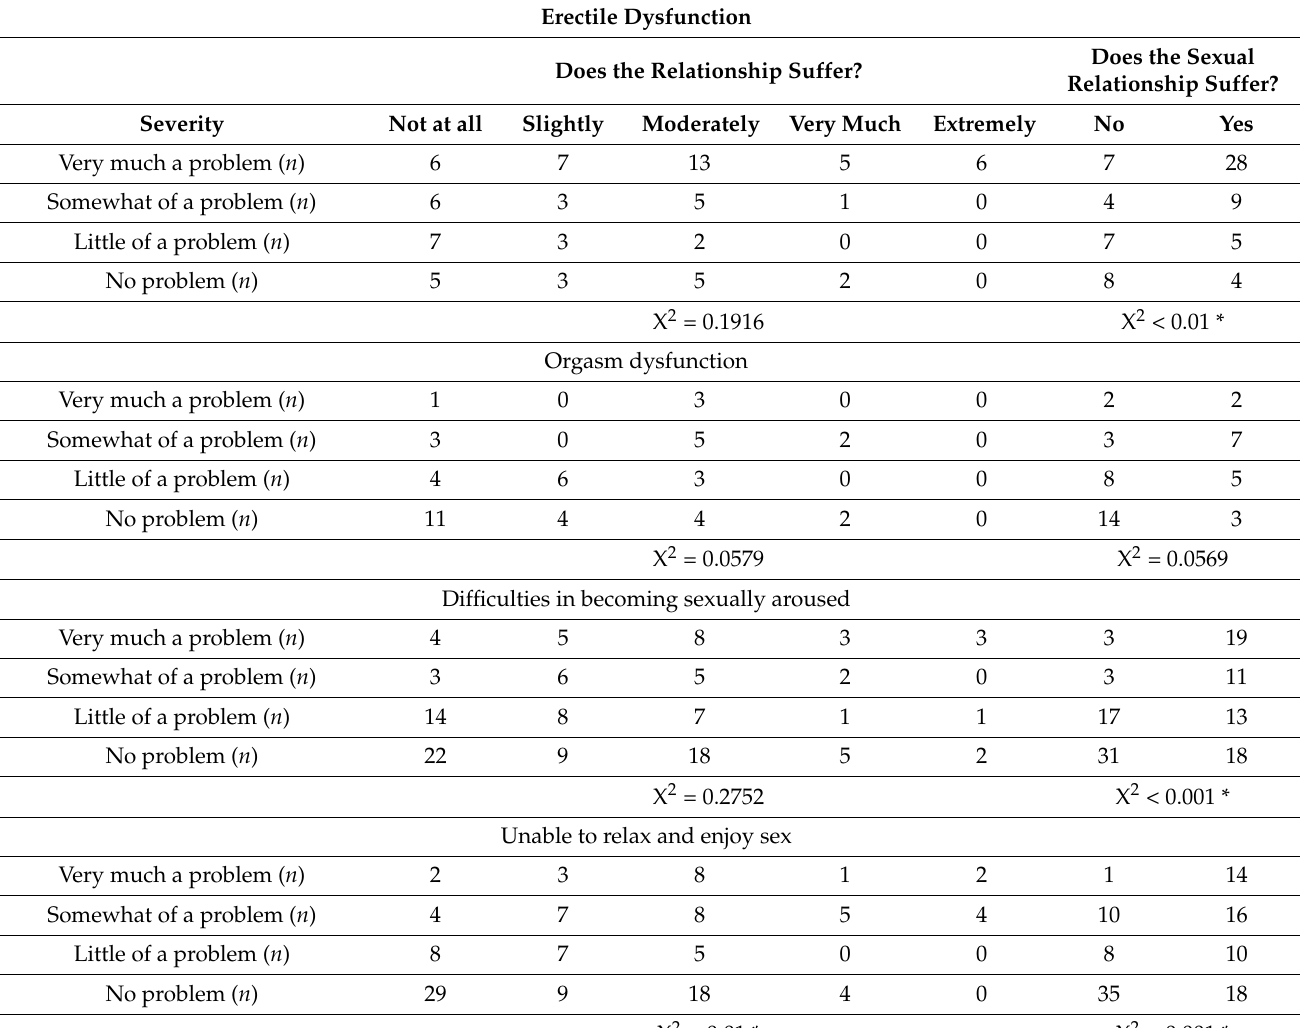
Table 2. Influence of sexual dysfunctions on the relationship. Erectile